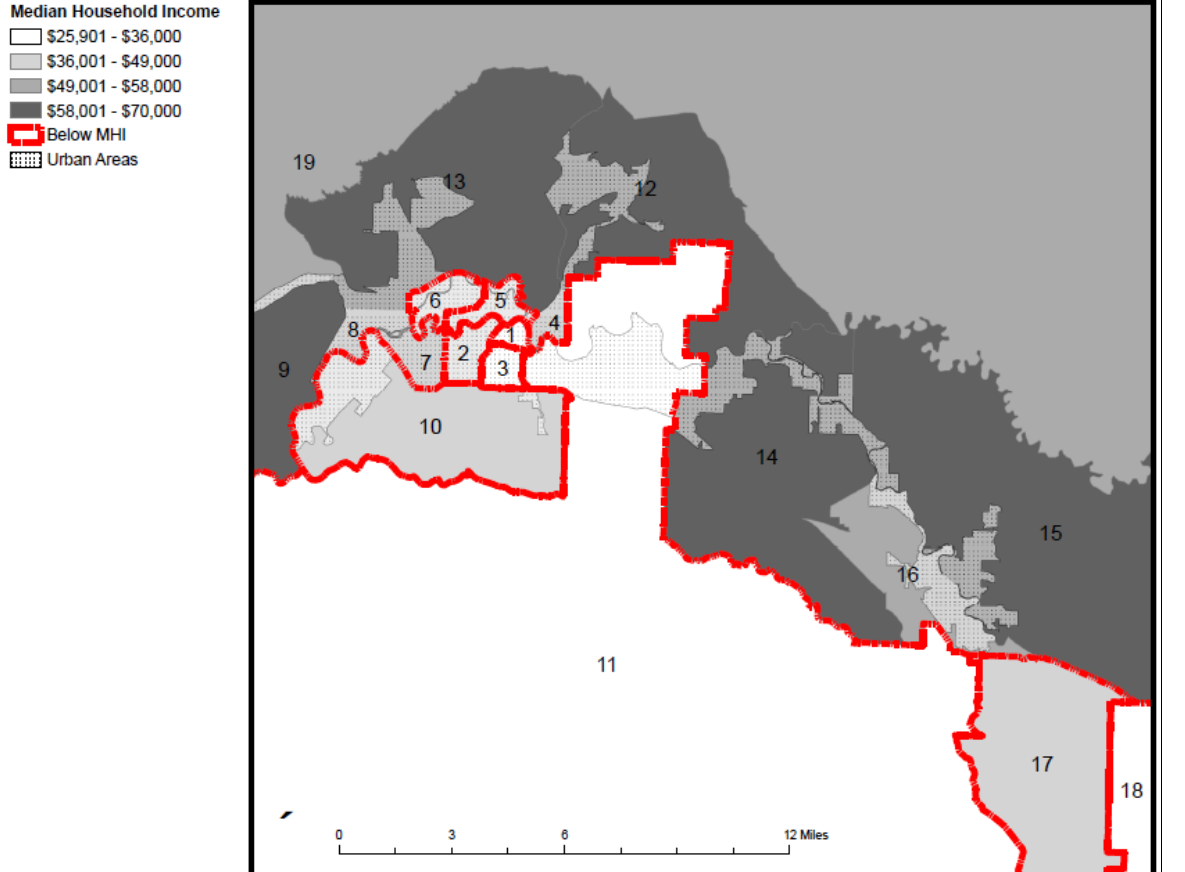
Figure 2. Fairbanks North Star Borough Census Tracts and 2000 Median Household